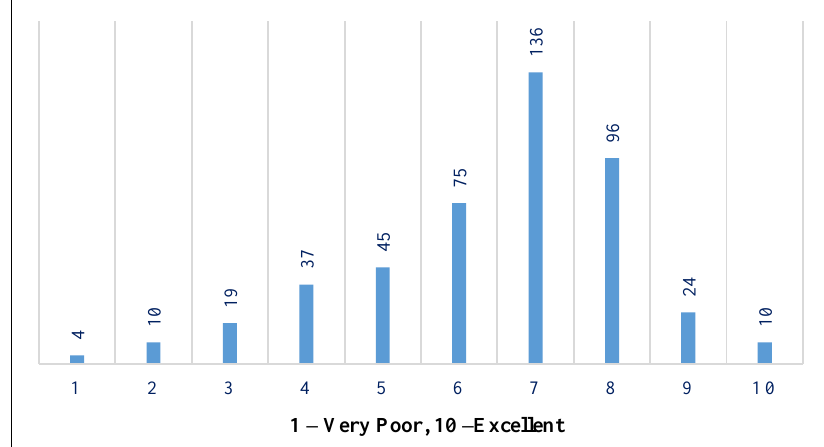
Figure 5. The overall evaluation of the distance learning study process at LLU during the COVID-19 pandemic, n=456 (1 – very poor, 10